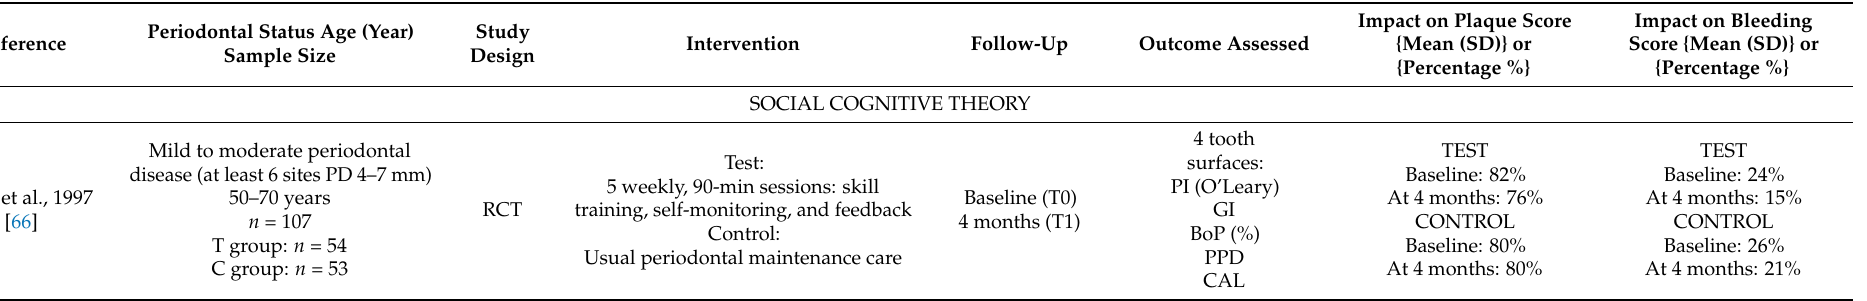
Table 3. General information of the included studies exploring the impact of psychological models of health-related behavior on the behavior and periodontal status of patients with periodontal